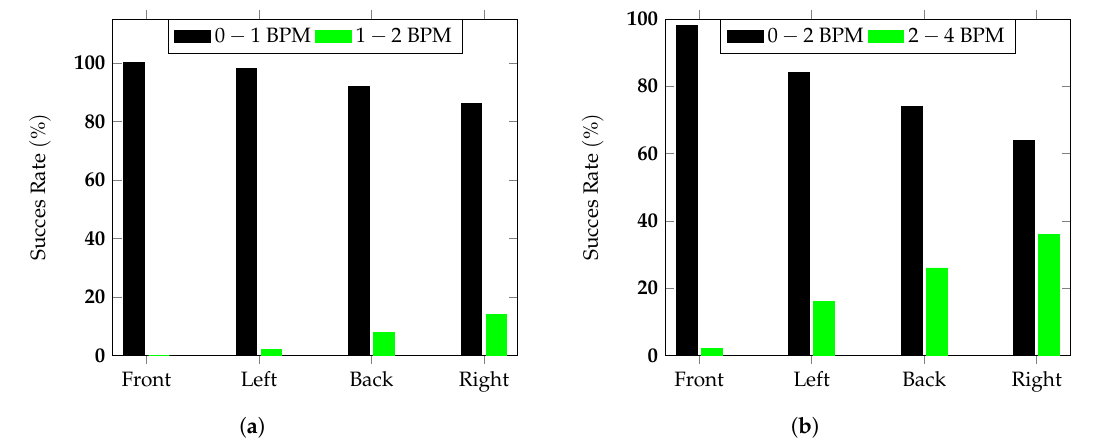
Figure 14. Success rate of the radar measurements ( a ) for the respiration rate and ( b ) for the heart rate. For the measured subjects, independently of the orientation, the respiration rate error stayed under 2 BPM in 100% of the measurements and 100%, 98%, 92%, and 86% under 1 BPM when the chest, the left side, the back, and the right were towards the antenna, respectively. For the hearth rate, all the measurement errors stayed under 4 BPM and under 2 BPM for 98%, 84%, 74%, and 64% for the front, left, back, and right orientations,